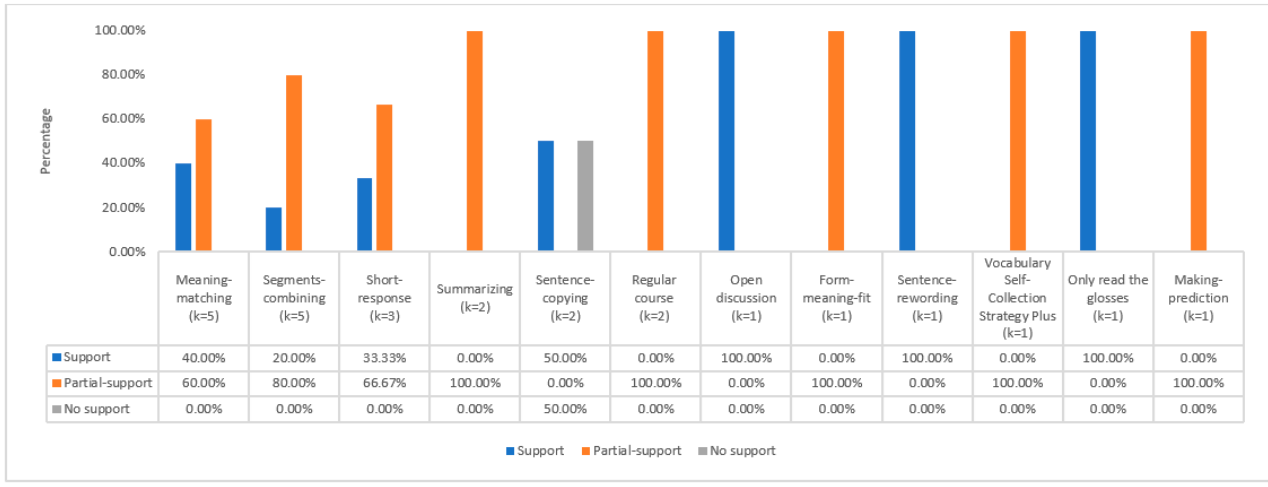
Figure 12. Low-frequency task types and ILH support in studies.